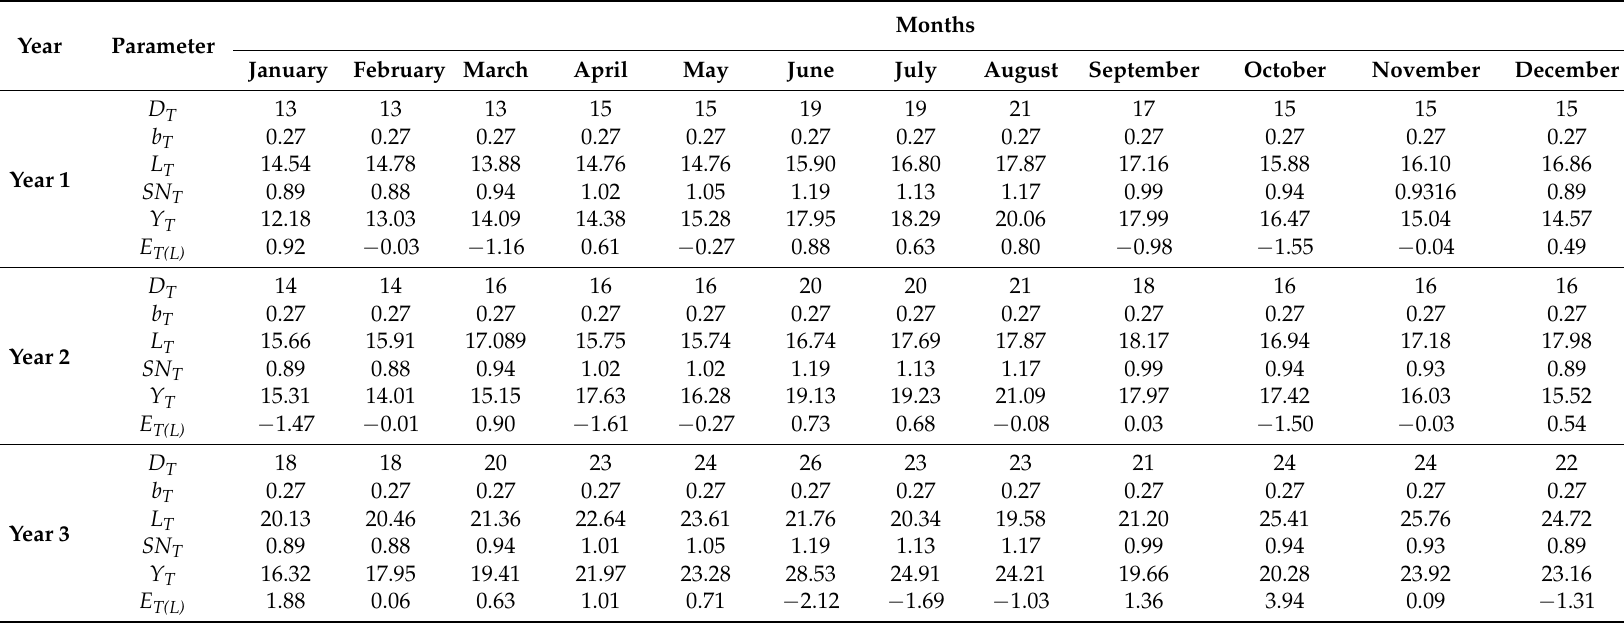
Table 1. Parametric values based on conventional Holt-Winters